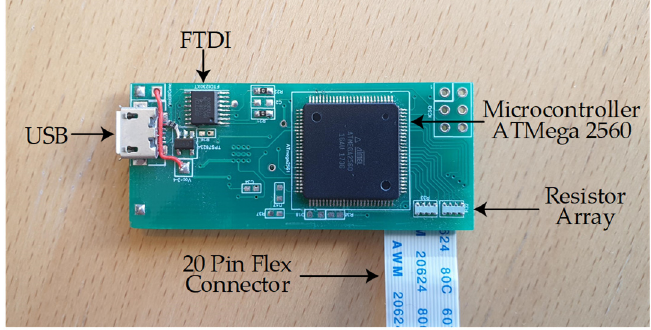
Figure 4. Read-out electronics on a 5 cm × 2 cm PCB.